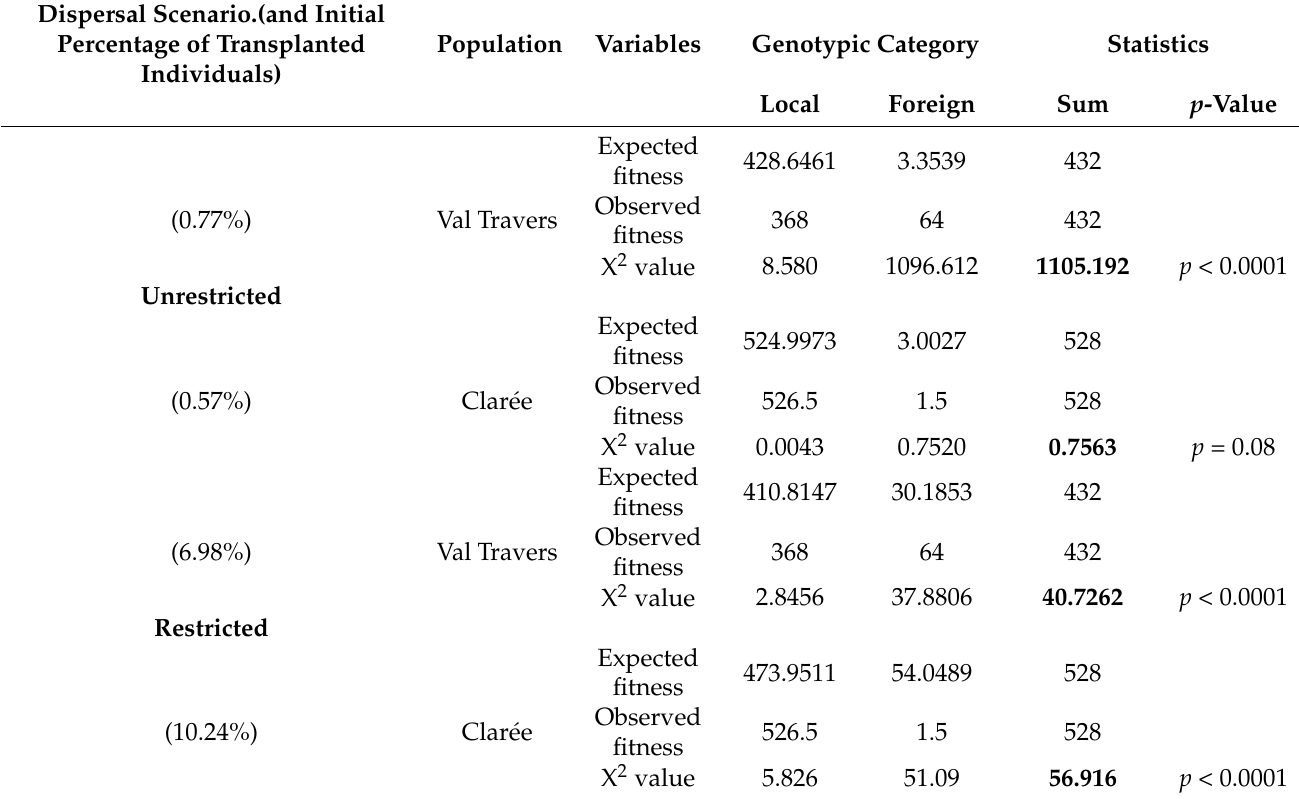
Table 1. Goodness-of-fit Tests on the observed fitness (estimate of the number of offspring sired) for the C0 genotypic categories (local, foreign) in Val Travers and Clar é e populations, assuming two contrasted dispersal scenarios (unrestricted and restricted) conditioning the initial percentage of transplanted individuals in each population.